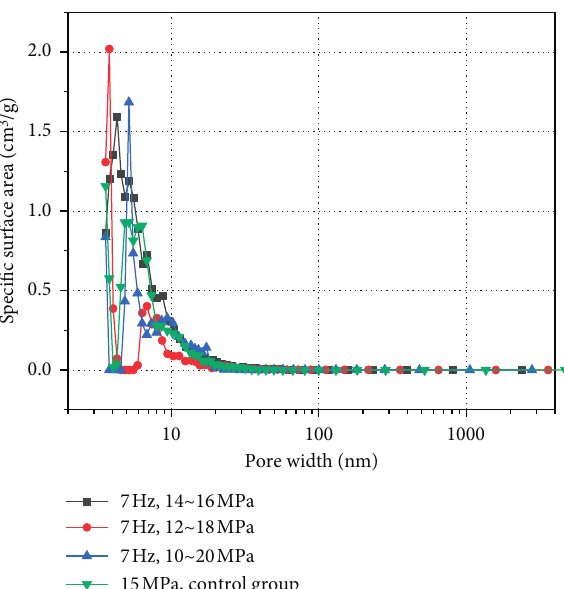
Figure 11: Distribution densities of the specific surface area of pores in coal mass at different loading